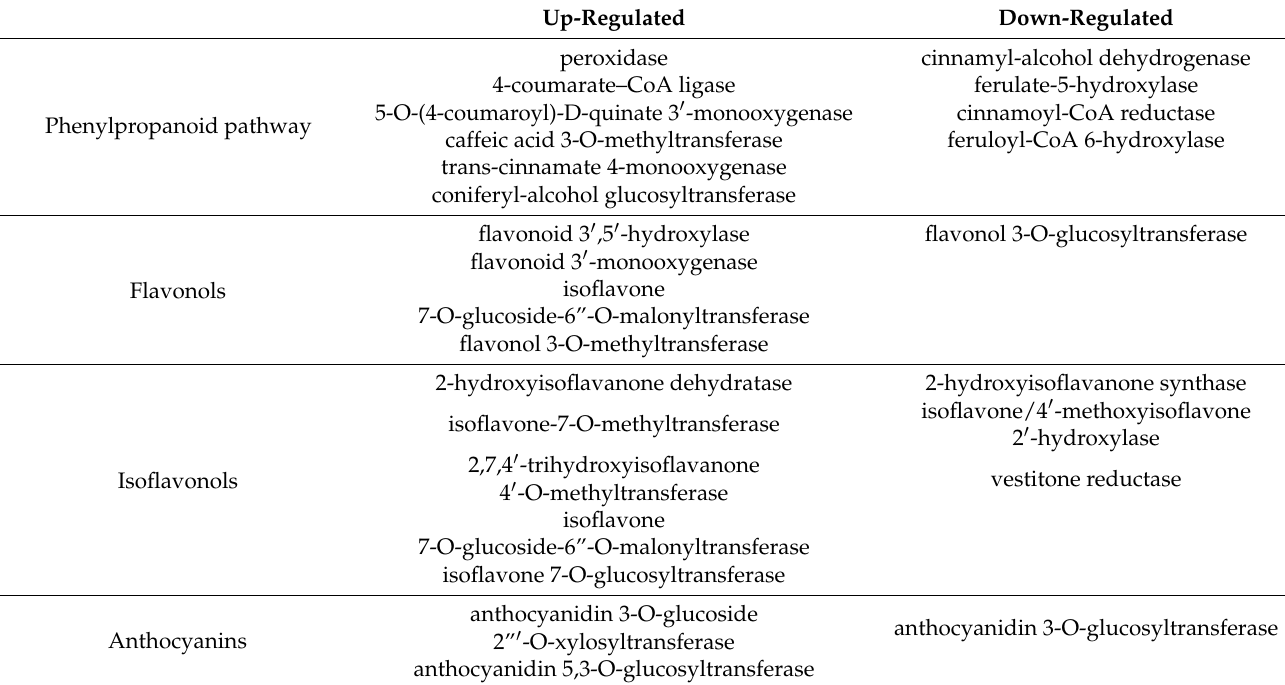
Table A9. Enzymes with the biggest difference in shikimate pathways (gall vs. LWG).